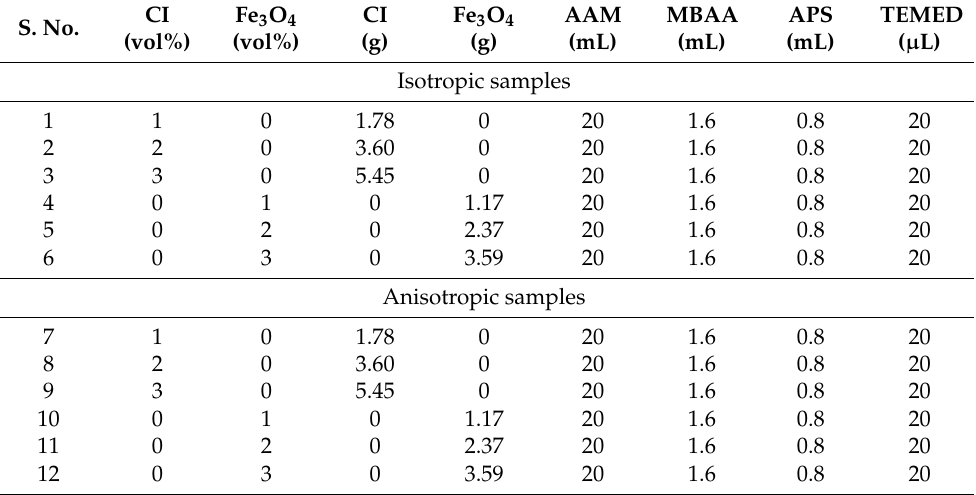
Figure 11. ( A ) Schematic illustration of the preparation procedure of magnetic hydrogels. ( B ) Pictures of pure hydrogel and magnetic hydrogels with isotropy and anisotropy of 2 vol% CI/Fe 3 O 4 . Table 2. Material